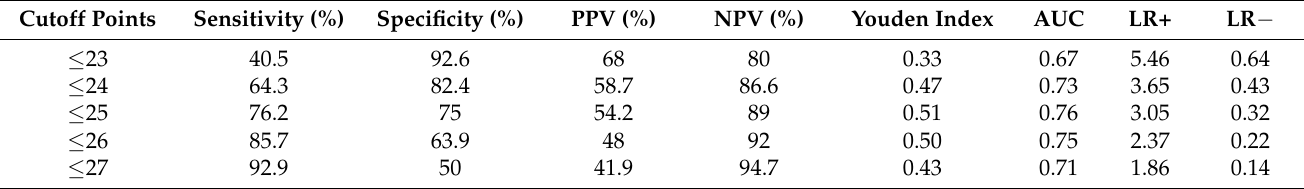
Table 2. The RUDAS-Thai performance on screening for MCI at different cut-off points. Cutoff